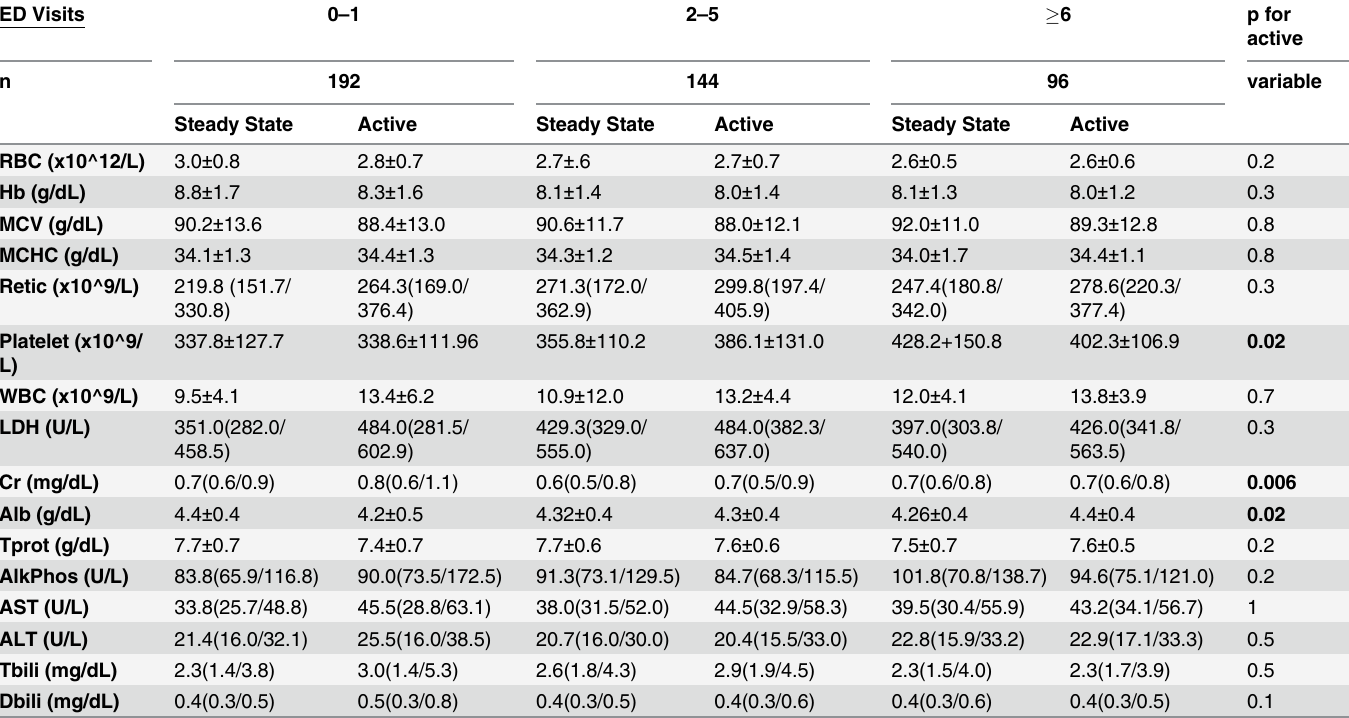
Table 3. Laboratory parameters during steady state and during “ active ” (1 day within ED visit or 1 week within a hospital admission) state. Normal- ized data reported as means with SDs, non-normalized data reported as medians with 25% and 75% P values are for ANOVAs done over all 3